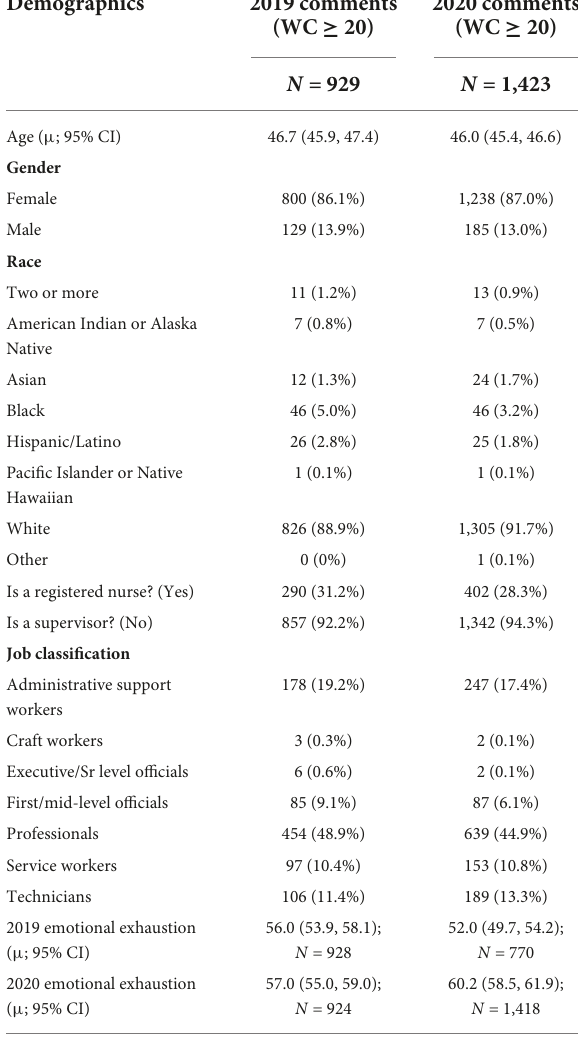
TABLE 1 Respondent demographics for surveys with 20 or more